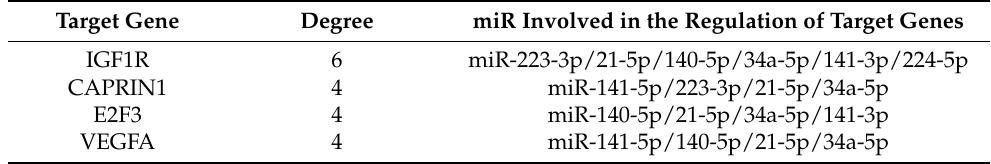
Table 5. Bioinformatic analysis (miRnet) of miRs involved in the regulation of odontogenic differenti- ation of human dental pulp and apical papilla stem cells showing the top four target genes with the highest degree in the miR-mRNA regulatory network.